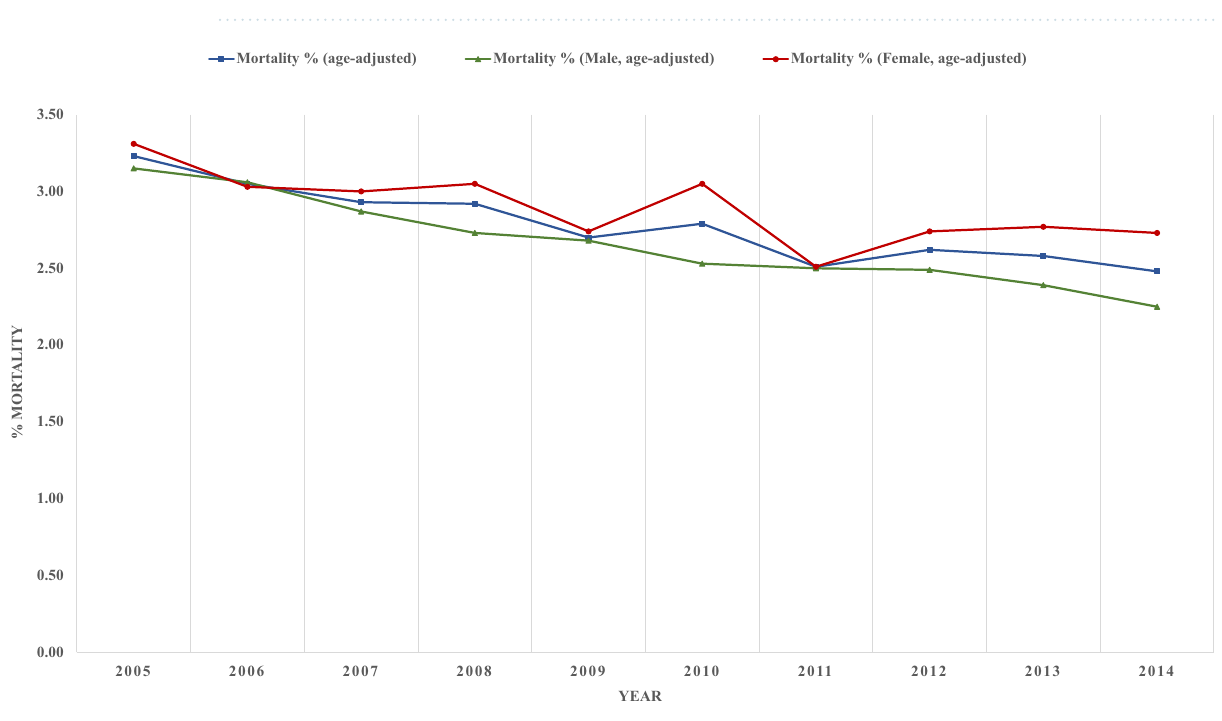
Figure 3. In hospital mortality among patients with diabetes admitted for hemorrhagic stroke.